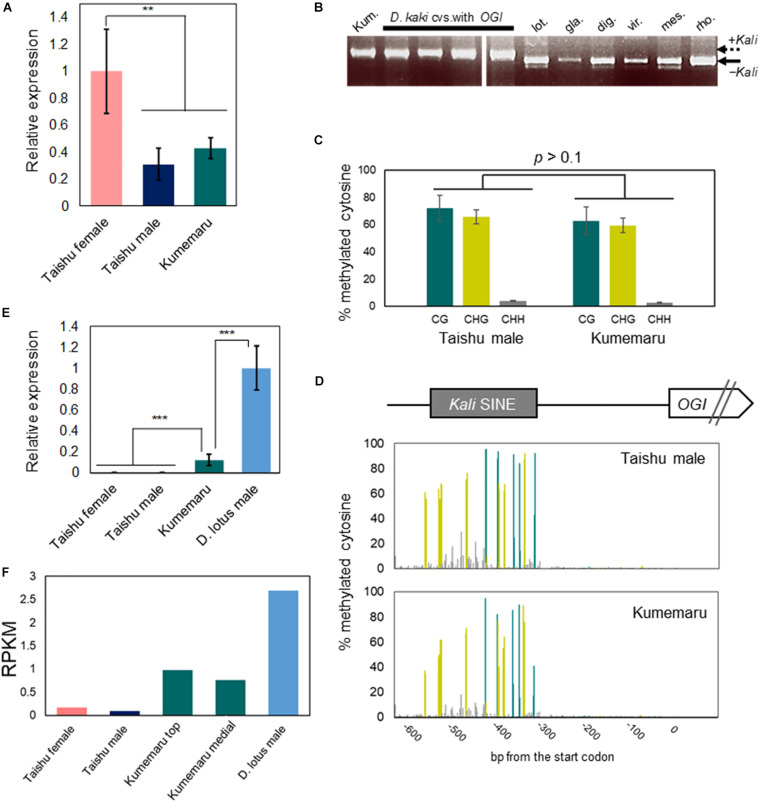
Regulation of OGI and MeGI in cv. Kumemaru. (A)
MeGI expression level in flower buds in cv. Kumemaru, and monoecious cv. Taishu, from qRT-PCR analysis. cv. Kumemaru showed substantial reduction in the MeGI expression, similar to male flowers of cv. Taishu (**p < 0.01, N = 4 for biological replicates). (B) PCR analysis detecting the Kali SINE in D. kaki, and the relatives. cv. Kumemaru (Kum.) carries only the Kali inserted OGI, as well as other D. kaki cultivars (Akagi et al., 2016a). Other representative Diospyros species (lot. D. lotus, gla: D. glaucifolia, dig: D. digyna, vir: D. virginiana, mes: D. mespiliformis, and rho: D. rhombifolia) showed no Kali-SINE insertion in the OGI promoter region. (C,D) Cytosine methylation level (C) and methylation pattern at each cytosine residue (D) in the cv. Kumemaru and cv. Taishu OGI promoter region, in flower primordia. cv. Kumemaru showed similar methylation pattern with cv. Taishu (p > 0.1) (E,F)
OGI expression level in flower buds in cvs. Kumemaru, Taishu, and diploid male D. lotus (cv. Kunsenshi-male), from qRT-PCR (E) and mRNA-Seq (F) analyses. OGI is not fundamentally expressed in monoecious cultivars including cv. Taishu (Akagi et al., 2016a), while cv. Kumemaru showed significant increase in the OGI expression (E, ***p < 0.001, N = 4 for biological replicates). The OGI expression in cv. Kumemaru was still lower than in diploid D. lotus, which carries no Kali SINE in the OGI promoter (E) (***p < 0.001, N = 4 for biological replicates). Bars indicate standard errors.